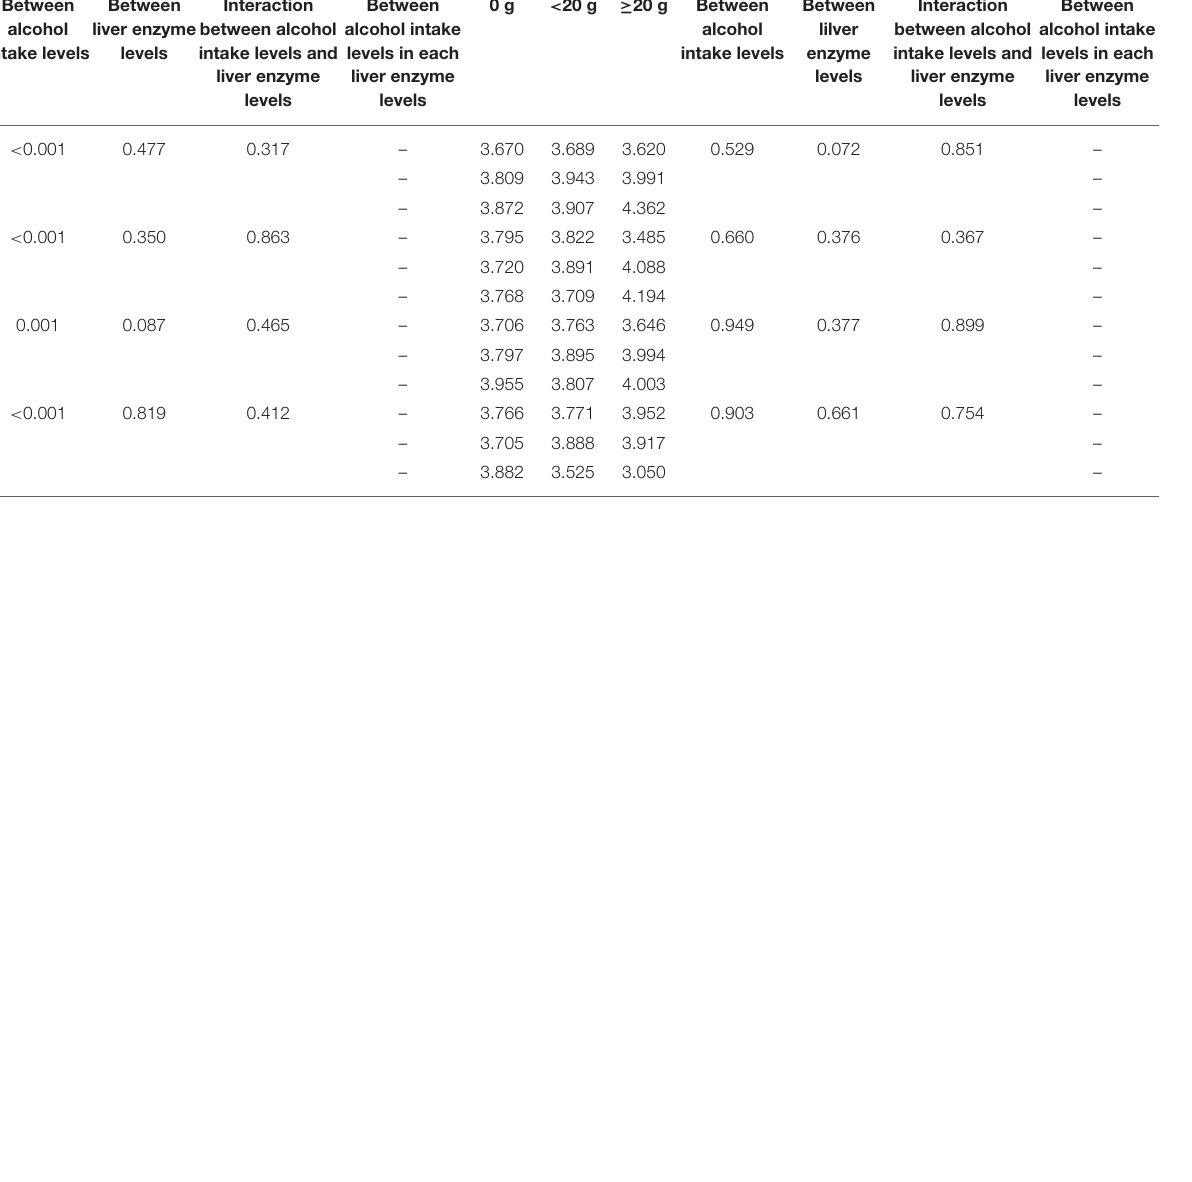
TABLE 4b | Comparison of serum selenoprotein P levels ( µ g/mL) among participants with different alcohol intake leves and different liver enzyme/fatty liver levels. Men